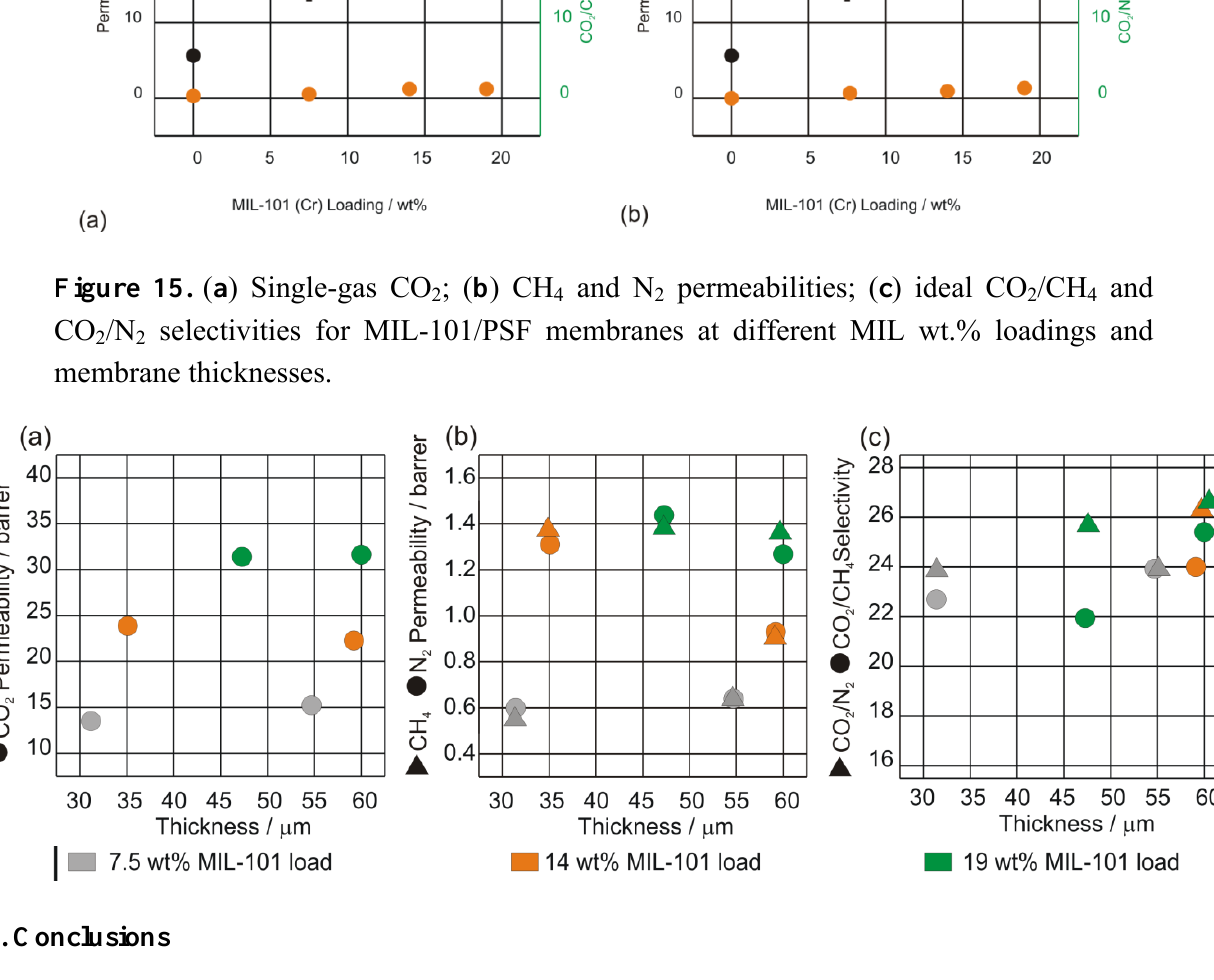
( b ) CO /N selectivities of pure PSF and MIL-101/PSF membranes with different 2 2 MIL wt.% loadings (averaged values for different membrane thicknesses).